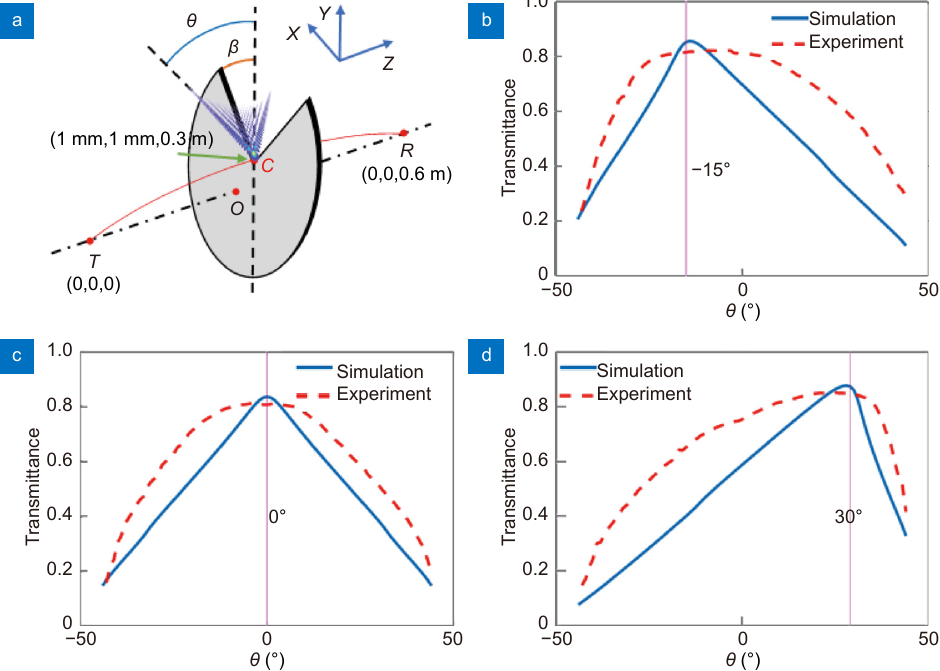
Fig. 5 | Obstacle evasion experiment. ( a ) set-up; normalized received optical power with obstacle’s angle β of ( b ) -15° ( c ) 0° and ( d ) 30°. (blue solid curves are calculated results, and red dotted curves denote the experimental